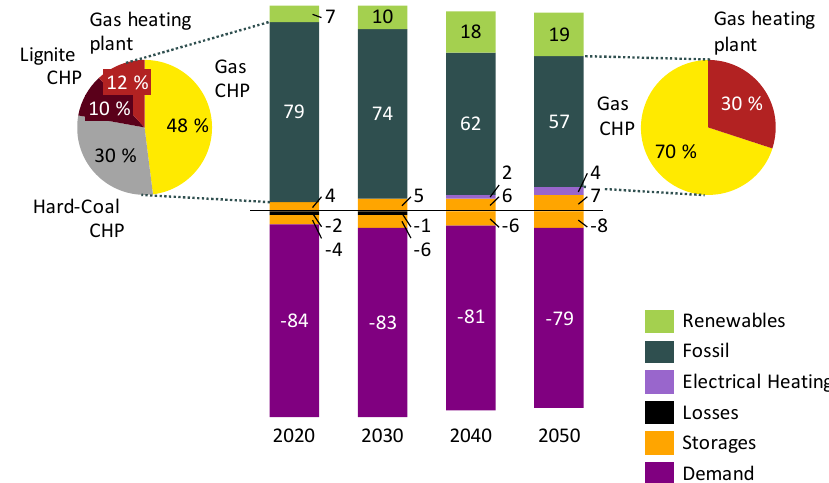
Figure A1. German energy carrier balance district heating in TWh.